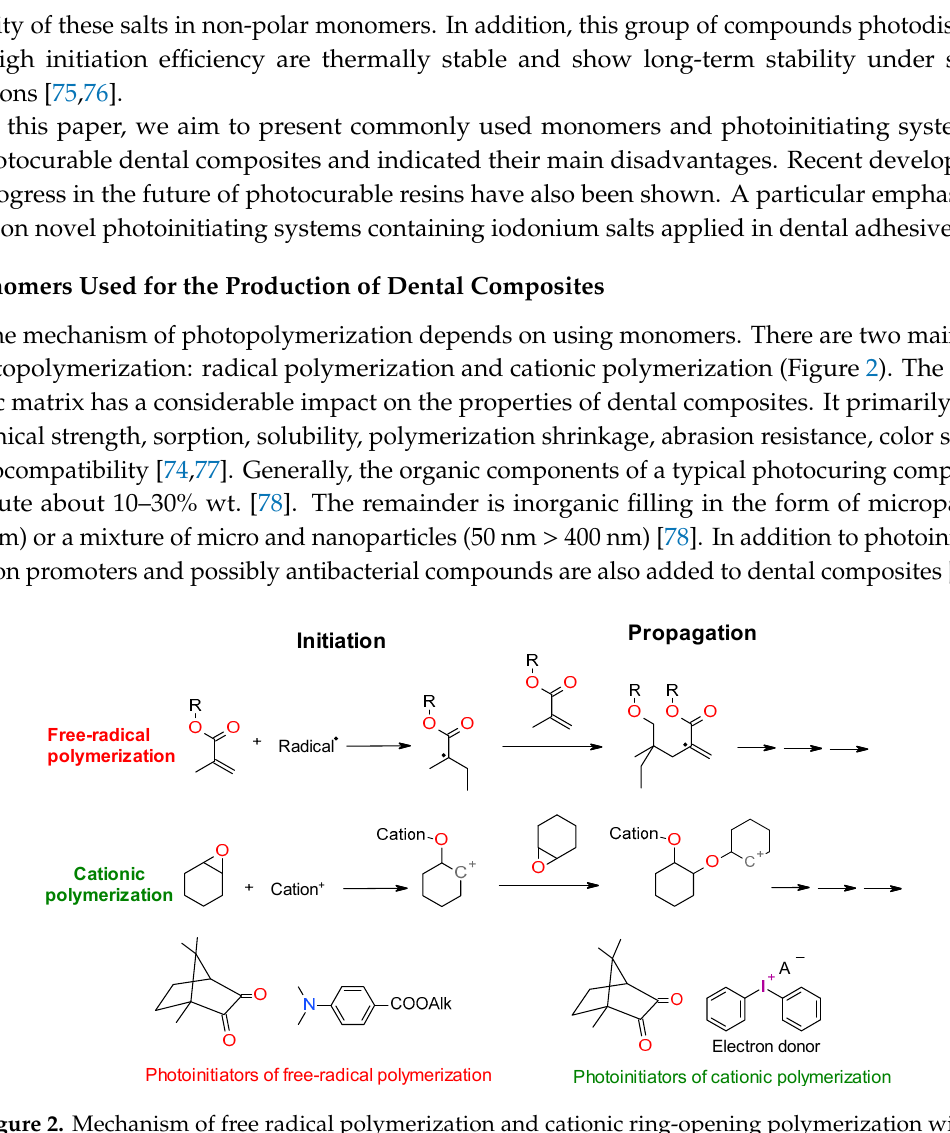
Figure 1. Illustrative diagram showing the influence of factors on the quality of obtained dental composites.